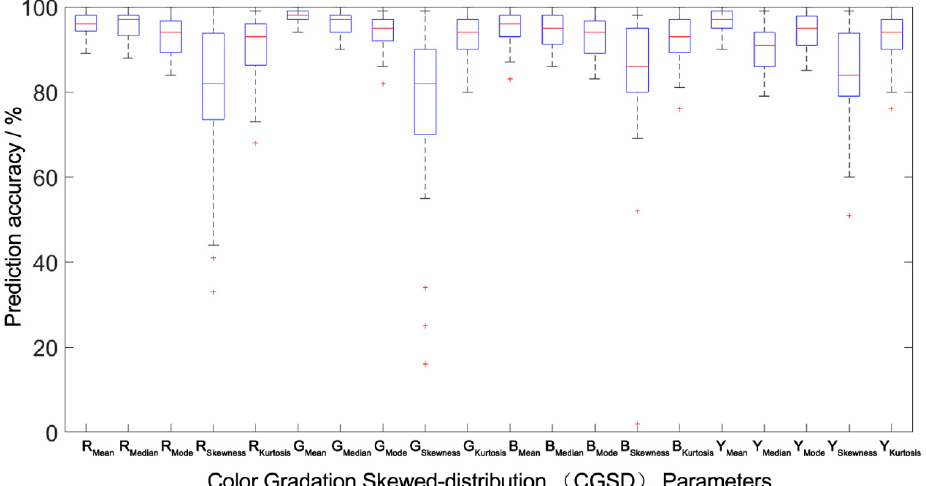
Figure 5. Prediction accuracy interval analysis of the population canopy color-meteorological re- sponse models of the modeling group. The Boxplot function of MATLAB was used to draw the accuracy percentile distribution diagram of the population canopy CGSD parameters prediction model. The blue box in the figure represents the prediction accuracy of the model distributed be- tween 25% and 75%. The shorter the box, the better the degree of data concentration. The red line in the box represents the median distribution of prediction accuracy, and the dotted line at both ends outside the box represents the endpoint value (maximum and minimum) of the prediction data dis- tribution. The shorter the distance between the two endpoint values, the better the degree of data concentration. The red cross outside the box represents abnormal data. The fewer abnormal data, the better the degree of data distribution concentration. Figure 6. Prediction accuracy interval analysis of the population canopy color-meteorological re- sponse models of the between-group. The Boxplot function of MATLAB was used to draw the ac- curacy percentile distribution diagram of the population canopy CGSD parameters prediction model. The blue box in the figure represents the prediction accuracy of the model distributed be- tween 25% and 75%. The shorter the box, the better the degree of data concentration. The red line in the box represents the median distribution of prediction accuracy, and the dotted line at both ends outside the box represents the endpoint value (maximum and minimum) of the prediction data dis- tribution. The shorter the distance between the two endpoint values, the better the degree of data